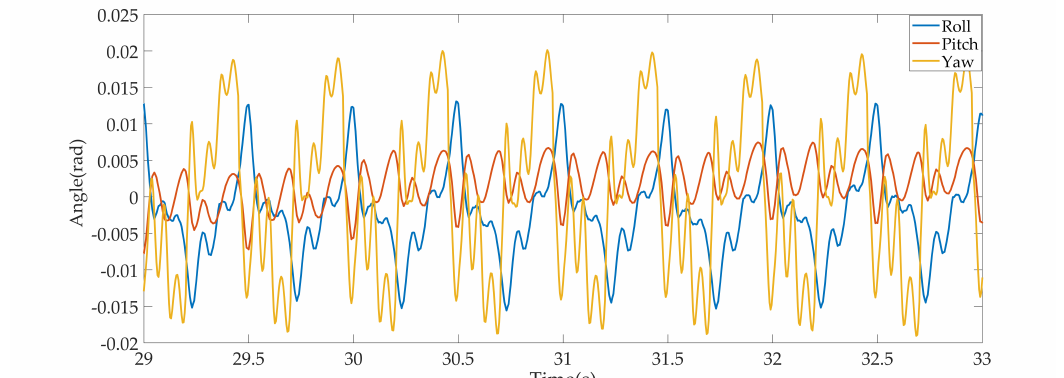
Figure 14. The attitude of the robot on the physical prototype experiment.